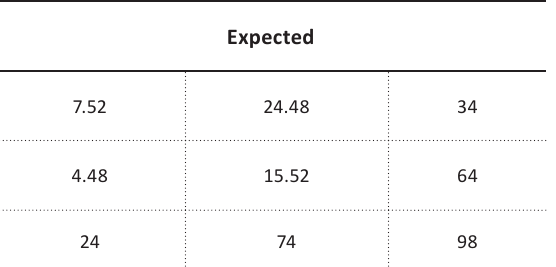
Source: Own survey.